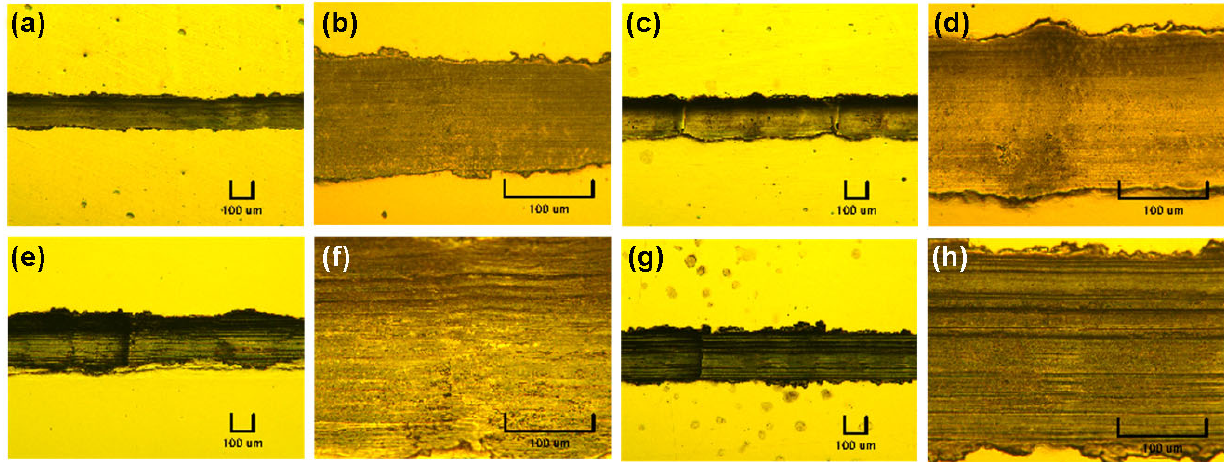
Fig. 9 Optical images of wear tracks on the steel disks after sliding 200 m and lubricated with (a and b) MO at room temperature, (c and d) 1 wt% DCi+MO at room temperature, (e and f) MO at 100 ºC, (g and h) 1 wt% DCi+MO at 100 ºC. Left images display with 50× zoom and right images display with 200× zoom.